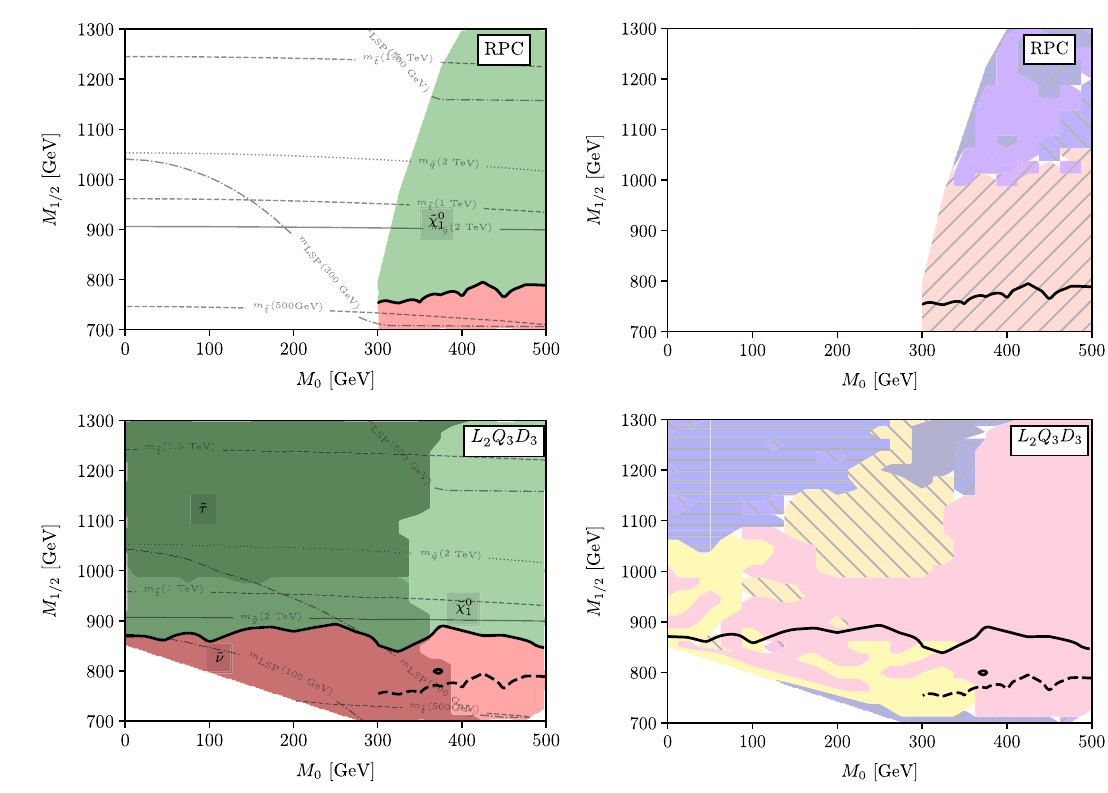
Fig. 17 Same as for Fig. 12, but this time using the parameter choices as in Fig. 3, i.e. with A 0 = − 2800GeV fixed, and λ (cid:4) also the change in M 0 and M 1 / 2 parameter ranges compared to Figs. 11, 12,13,14,15and16.Thismakesthe ˜ ν -LSPregionmorereadilyvisible.